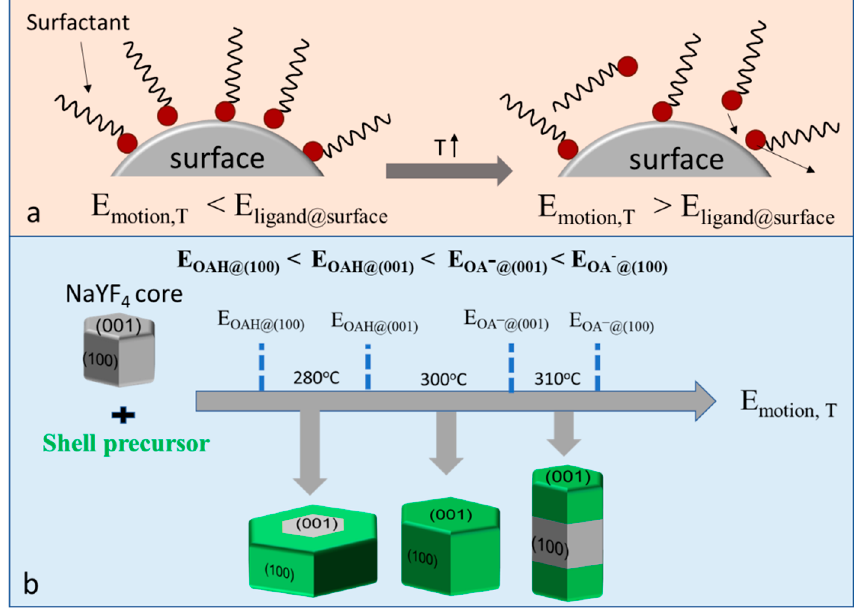
Figure 1. ( a ) Scheme of the relationship between the reaction temperature and the passivation status of surfactant ligands on the crystal surface: the thermal motion energy of the surfactant molecule ( E motion,T ) increases as the temperature rises. When E motion,T > E ligand@surface (surfactant binding energy on the crystal surface), the surfactant will have an increased chance of being shaken off from the surface. ( b ) Scheme of tuning the shell growth direction for hexagonal NaYF 4 nanocrystal by adjusting the reaction